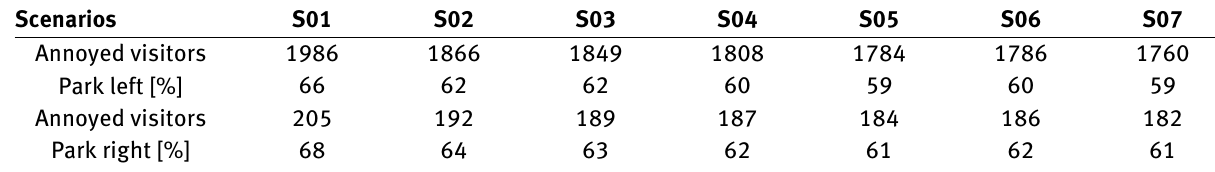
Table 8: Absolute and percent values for the amount of annoyed park visitors given separately for the left- and right- side of the park.